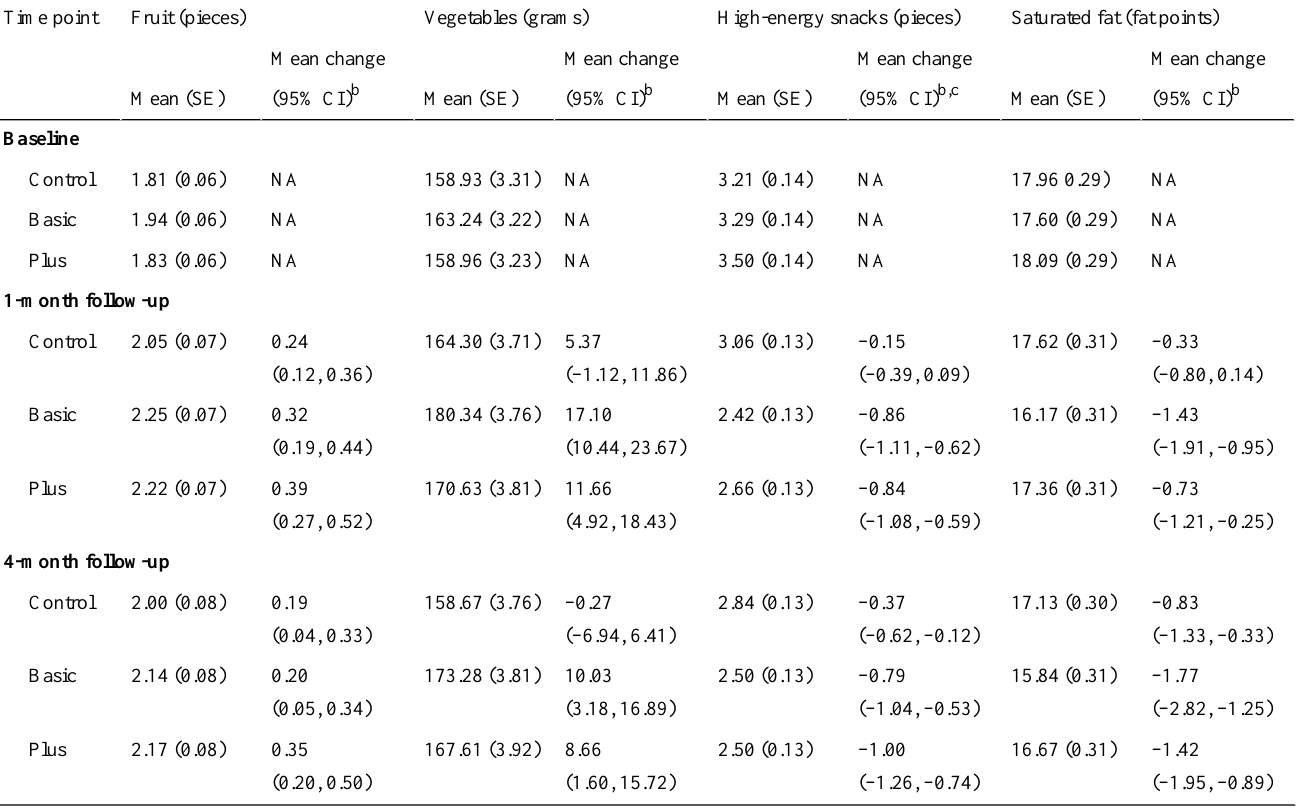
Table 2. Estimated marginal means at baseline and 1- and 4-month follow-ups and changes over time for the total sample (N=1349).